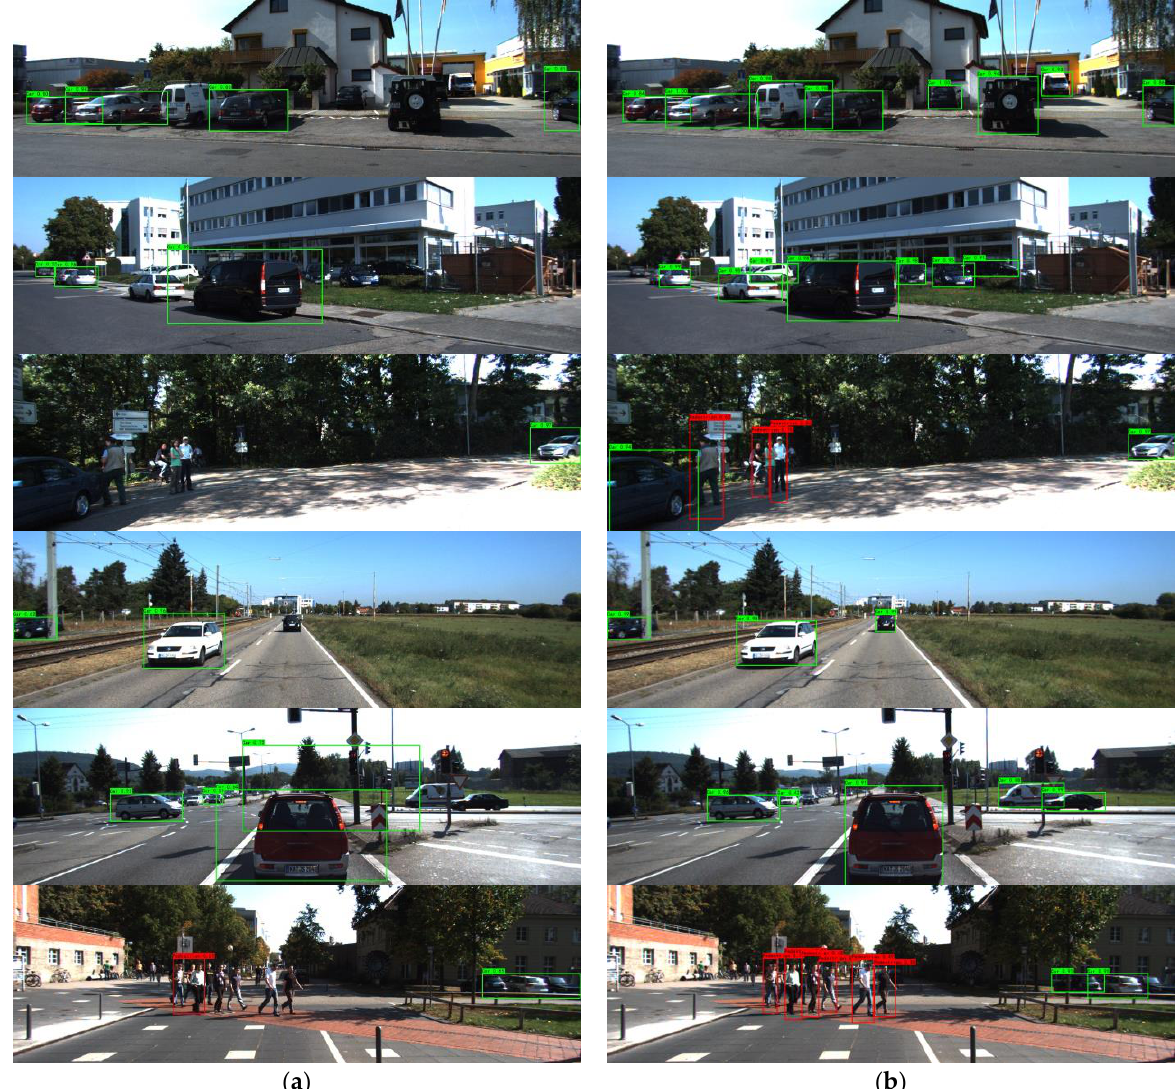
Figure 10. The mAP of the Model 4 in the KITTI dataset.